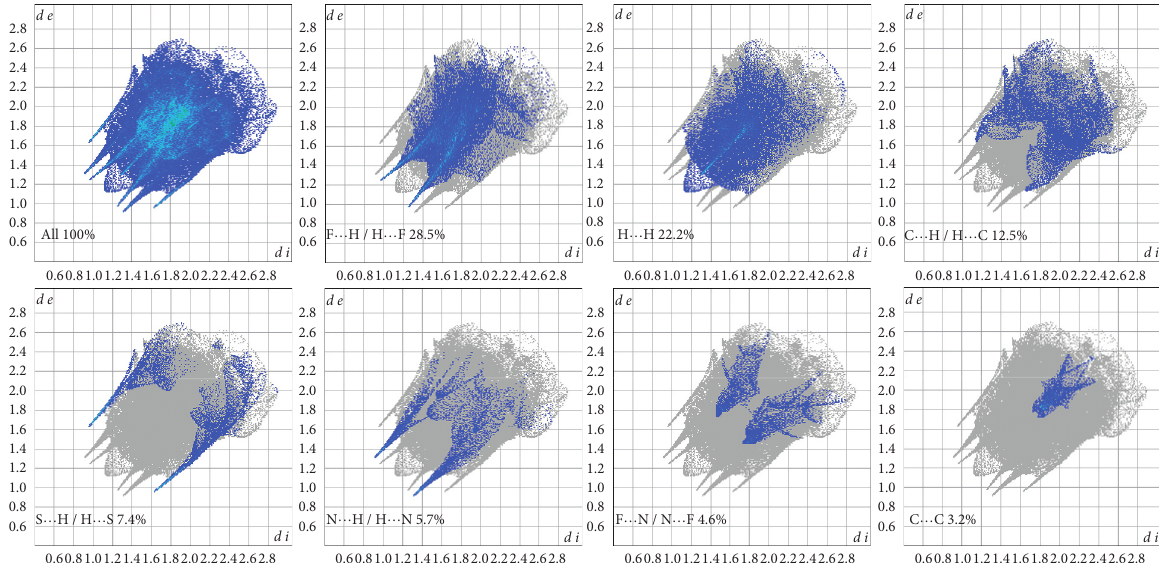
Figure 7: Selected fingerprint plots of the intermolecular interactions showing the percentage contributions to the total Hirshfeld surface.